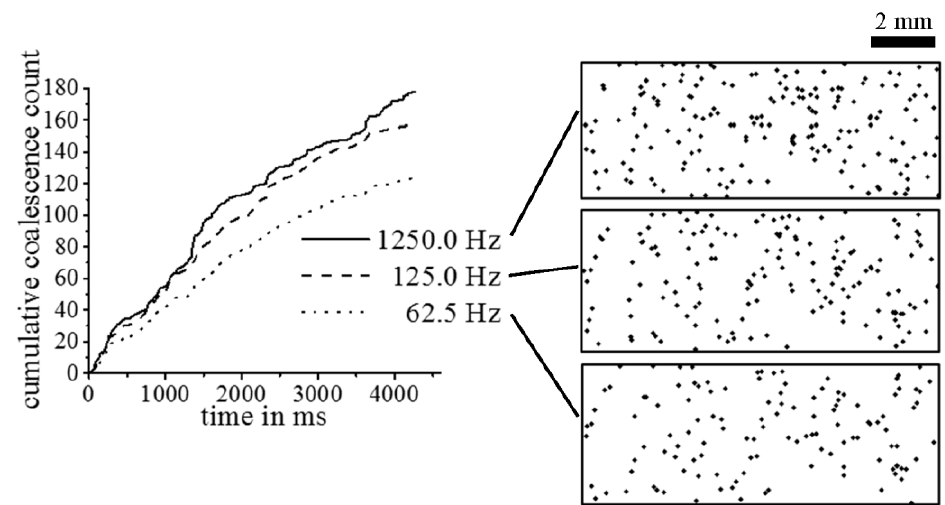
Figure 3. Cumulative coalescence count vs. time and coalescence maps of a uniaxially hot-compacted AlSi6Cu4 + 0.5 wt % TiH 2 sample detected with image acquisition rates of 1250 Hz (compact line), 125 Hz (dashed line), 62.5 Hz (dotted line) with corresponding coalescence maps.